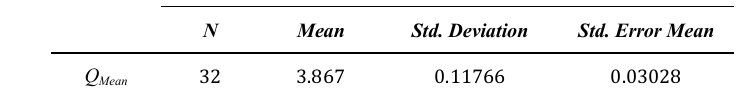
Table 5. One-Sample Statistics